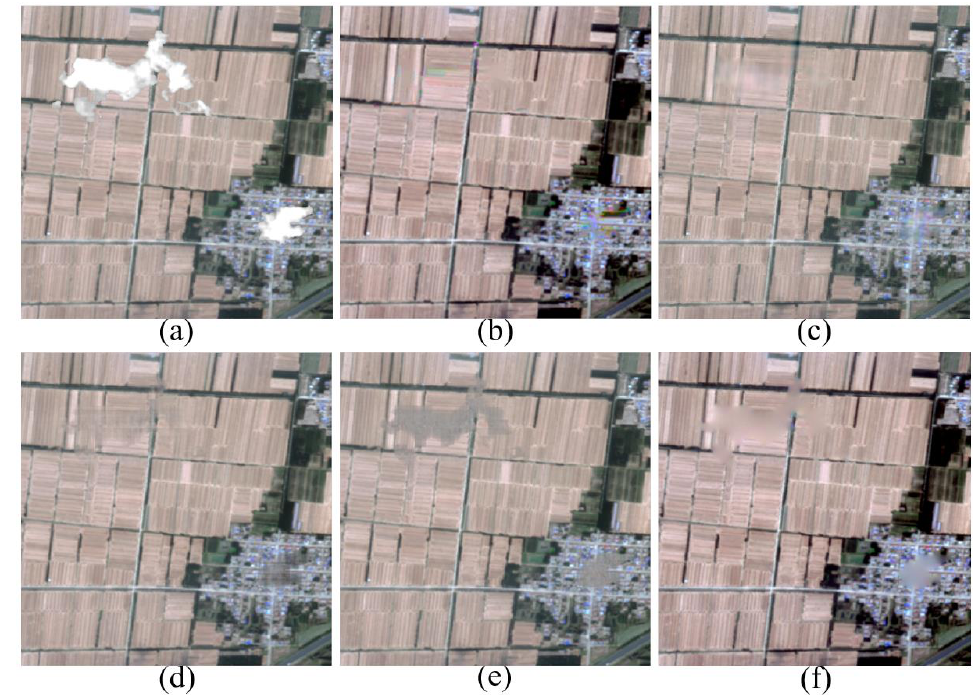
Figure 8. Comparison of Clouds Removal from GaoFen-2 RS Imagery. ( a ) GaoFen-2 RS Image (true color composites) with Clouds; ( b ) Cloud Removal by Our Inpainting Method; ( c ) Cloud Removal by MCA [46]; ( d ) Cloud Removal by FaLRTC [37]; ( e ) Cloud Removal by SiLRTC [37]; ( f ) Cloud Removal by MRF [35].